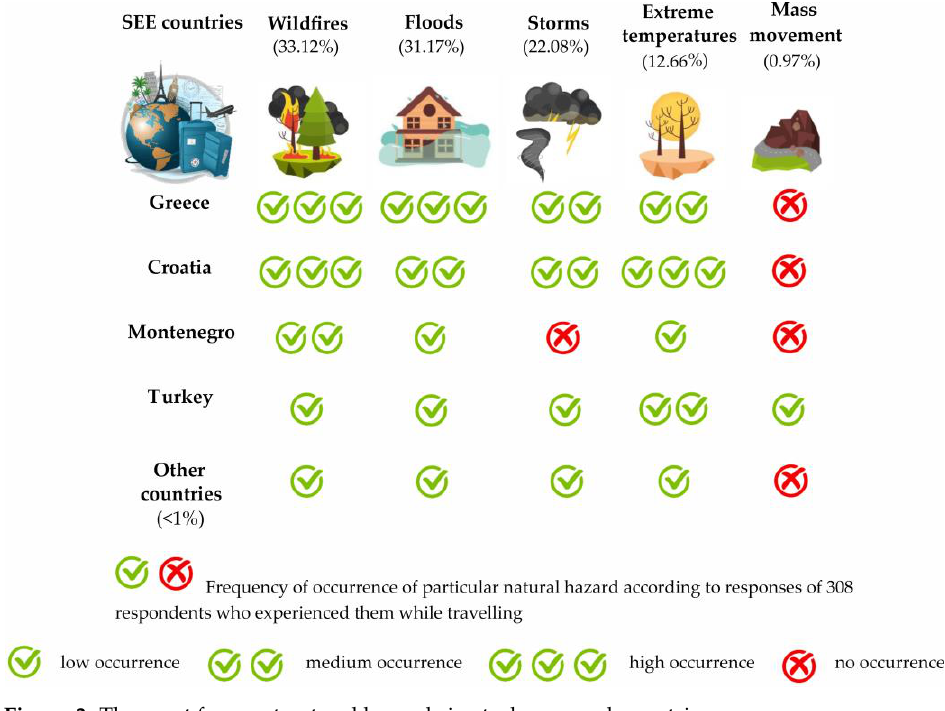
Figure 3. The most frequent natural hazards in study covered countries.